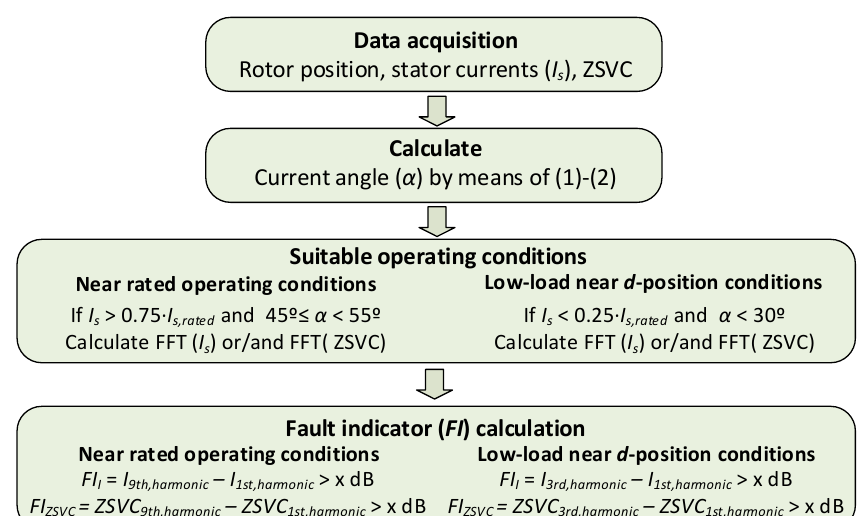
Figure 11. Flowchart of the proposed approach including the fault indicators.